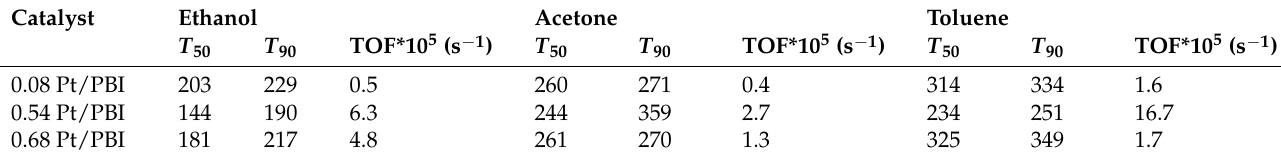
Figure 11. Conversion curves of ethanol ( a ), acetone ( b ), and toluene ( c ) over the investigated catalysts. Reaction conditions: 0.2 g of catalysts, 1000 ppm of VOC, GHSV 20 L g cat − l h − l , temperature ramp 2 °C min − l . Table 2. Temperatures T 50 and T 90 and turn-over frequency TOF in the oxidation of ethanol, acetone, and toluene. Reaction conditions: 0.2 g of catalyst, 1000 ppm of VOC, GHSV 20 L g cat − l h − l , temperature ramp 2 °C min −l .